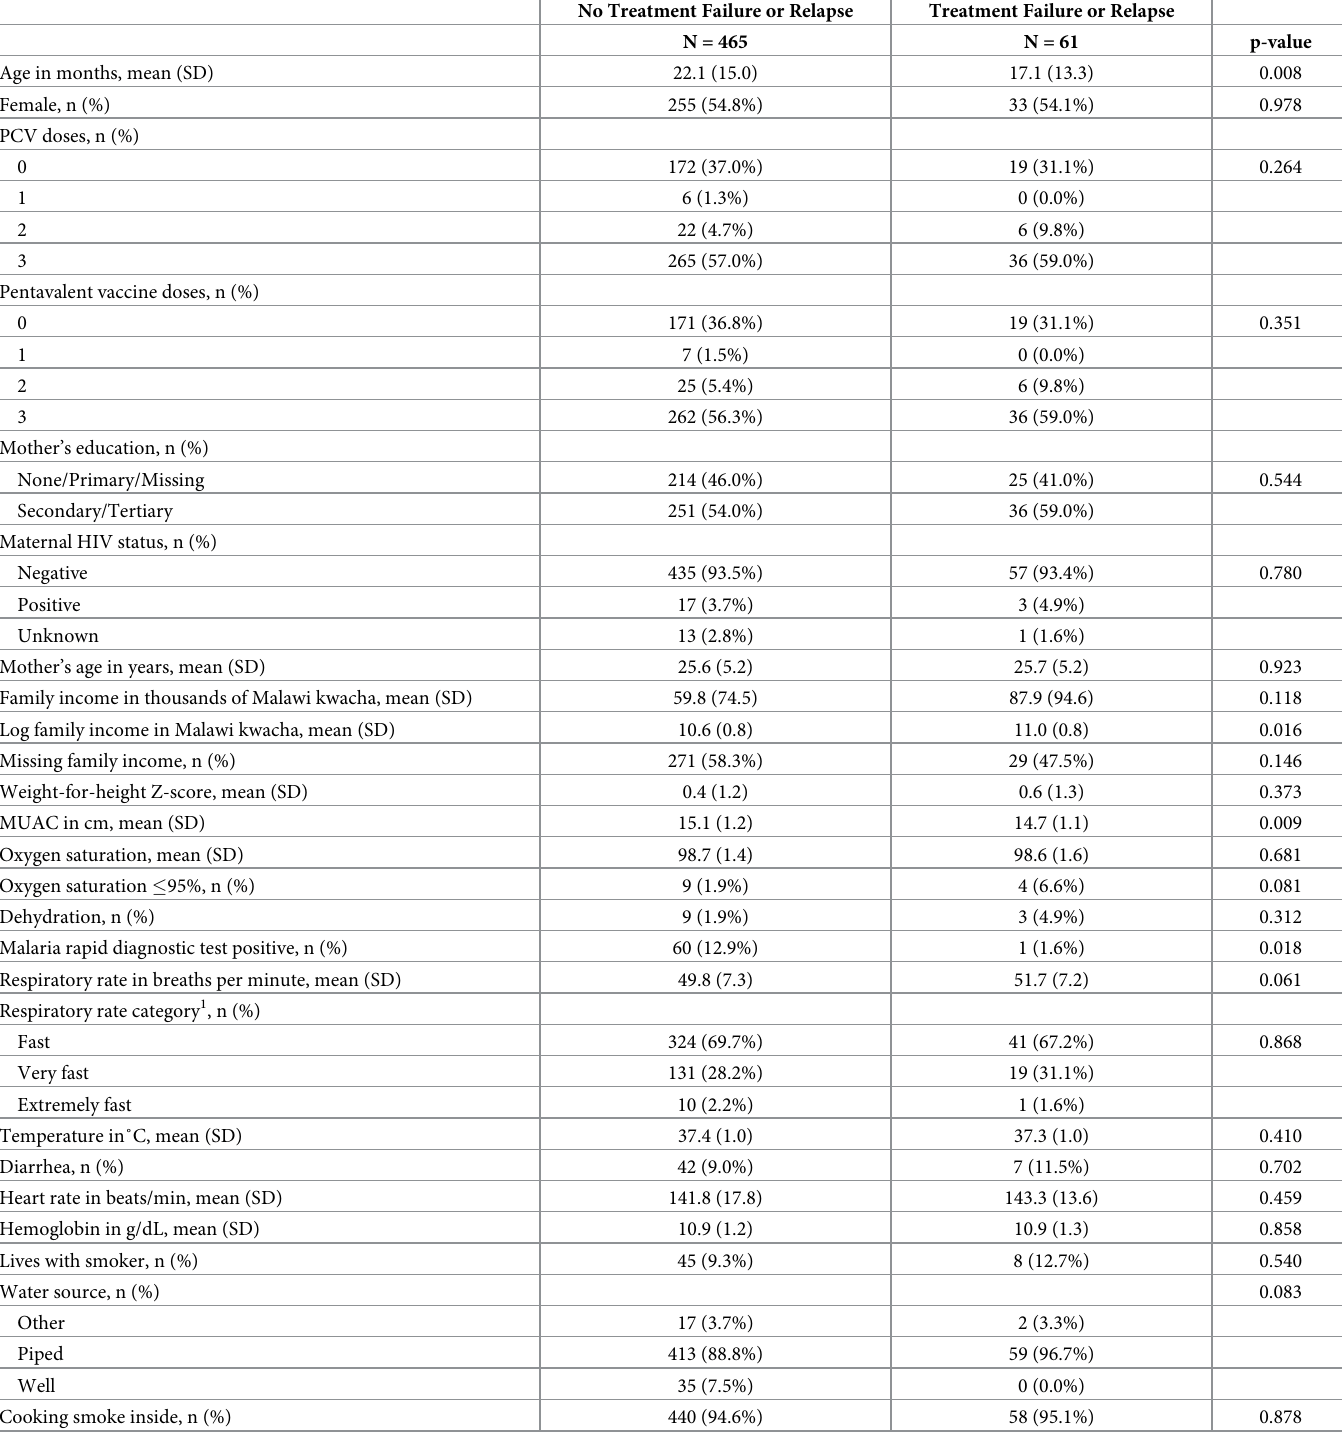
Table 3. Baseline characteristics of placebo recipients according to